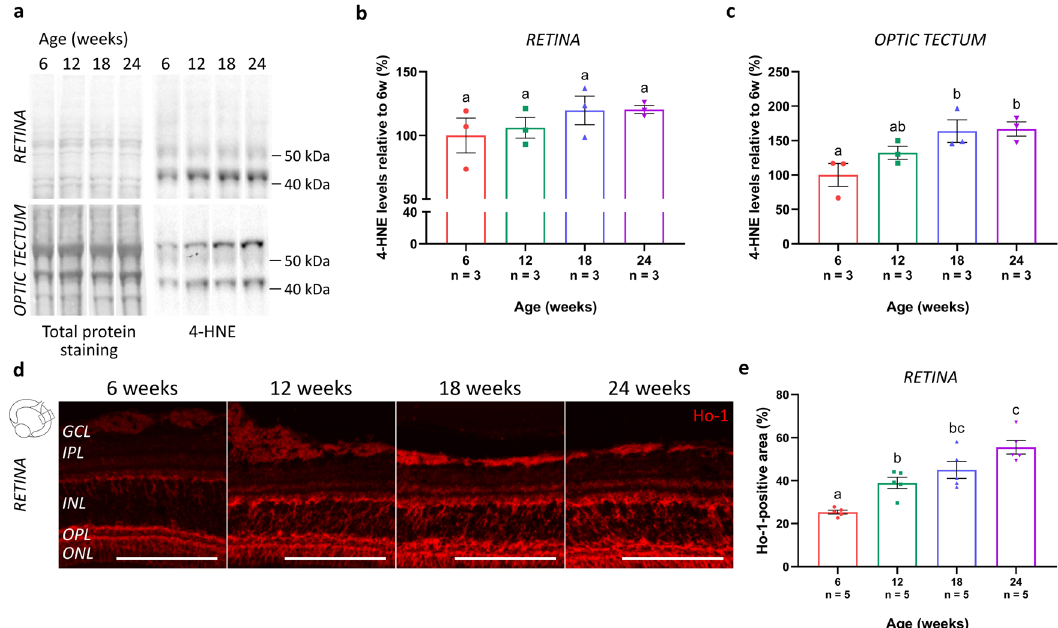
Fig. 2 Elevated levels of oxidative stress in the aged killi fi sh retinotectal system. a Representative western blot images revealing 4-HNE in the retina and optic tectum of fi sh of the various age groups. Quantitative analysis discloses a tendency to increased levels in the retina ( b ), and a signi fi cant age-related increase of 4-HNE levels in the optic tectum of fi sh of 18 weeks and 24 weeks old ( c ). All blots derive from the same experiment and were processed in parallel. Full-length blots are presented in Supplementary Fig. 3. n = 3. d Microscopic pictures of Ho- 1-labeled retinal cryosections show an elevated expression of this enzyme with increasing age, especially visible in the INL. Scale bar = 100 µm. e Quanti fi cation of the area occupied by the Ho-1-positive signal in the retina, expressed relative to its measured surface area, reveals a signi fi cant age-associated upregulation in the killi fi sh retina. n = 5. All values are shown as mean ± standard error of mean, statistical signi fi cance between different conditions is depicted using different letters. 4-HNE 4-hydroxynonenal, Ho-1 heme oxygenase 1, GCL ganglion cell layer, IPL inner plexiform layer, INL inner nuclear layer, OPL outer plexiform layer, ONL outer nuclear